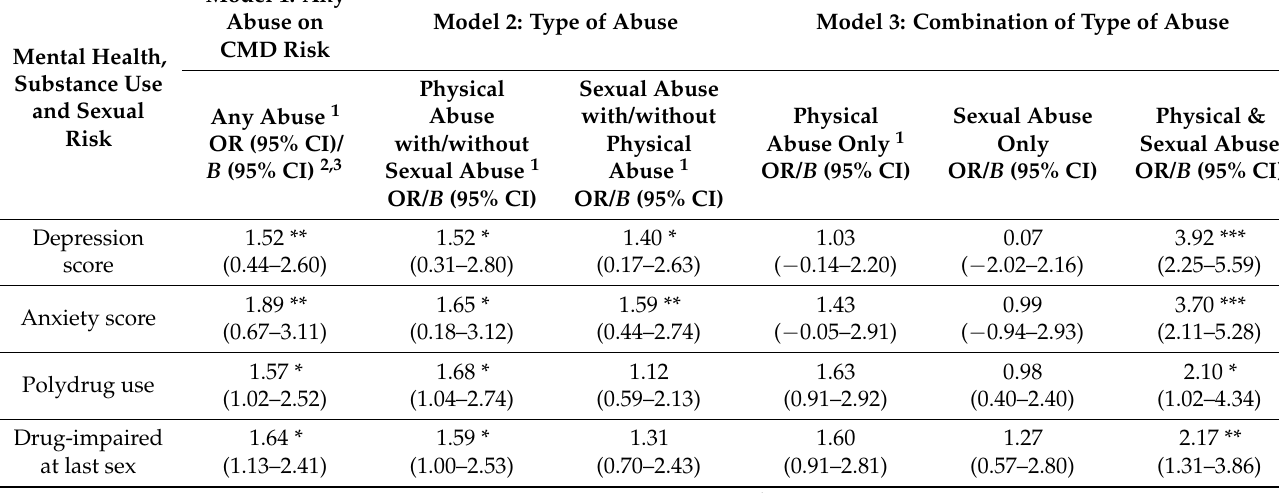
Table 2. Associations between type and combination of abuse exposure and mental health, substance use, and sexual risk among young women who use substances in Cape Town, South Africa ( n = 499) 1